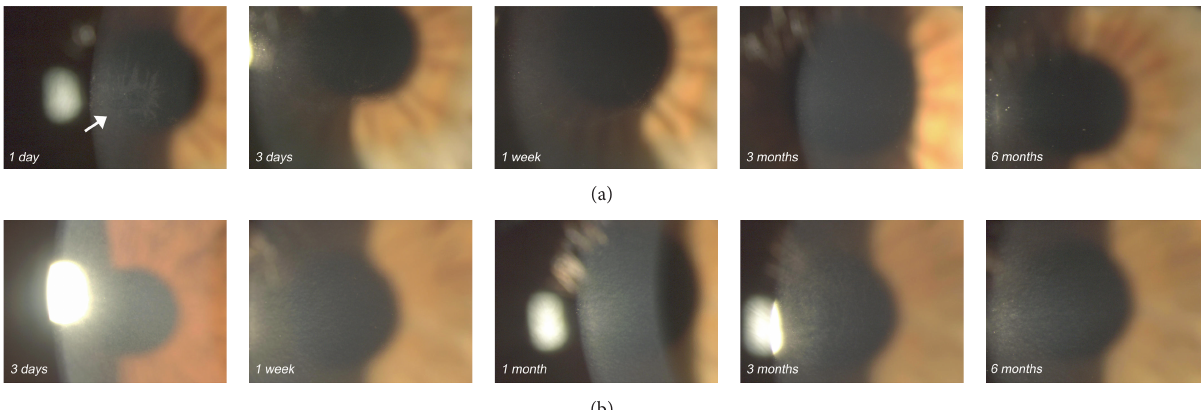
Figure 2: (a) Slit-lamp photographs of a representative case (A1200) after T-ionto CL. One day after treatment, moderate epithelial haze of the central cornea (arrow), with no fluorescein staining, was noted in 5 cases (23%); this superficial haze regressed in all cases within 1 week after treatment. Six months after T-ionto CL, the cornea was clear in all cases. (b) Slit-lamp photographs of a representative case (B700) after standard CL. Six months after treatment, anterior corneal haze and mild stromal edema, which was confined to the posterior stroma, were still observed in 50% and 8% of controls, respectively.